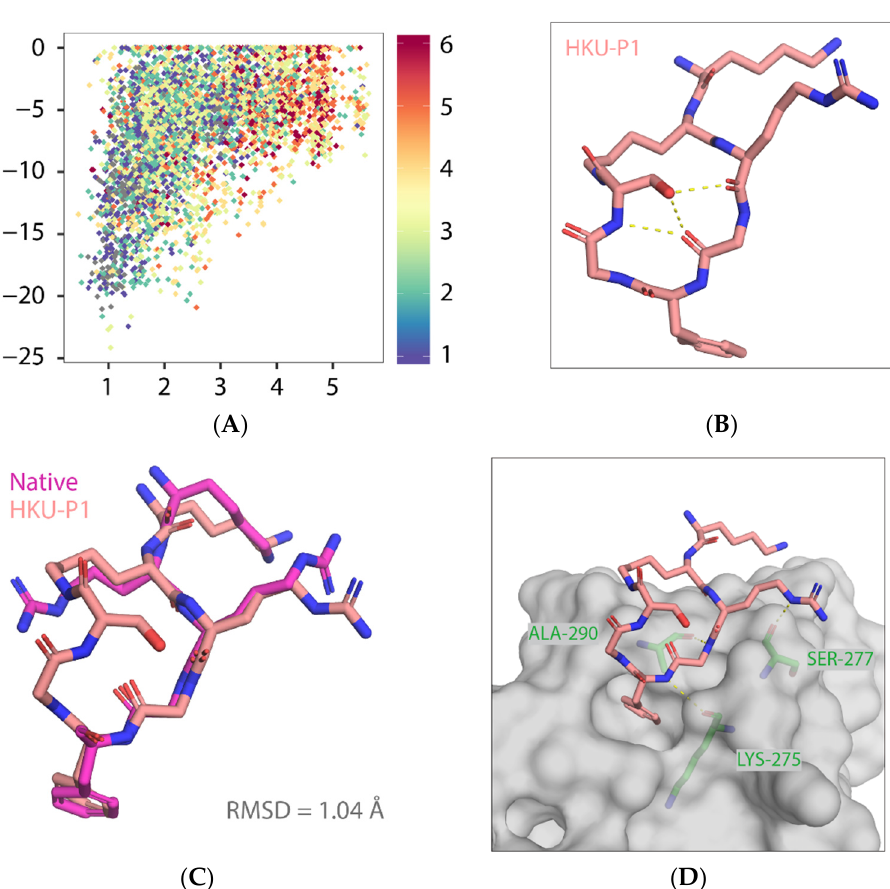
Figure 4. Predicted binding mode of HKU-P1 to SFTSV Gn. ( A ) Conformational landscape analysis of HKU-P1 bound to SFTSV Gn, showing computed binding energy against RMSD to native pentapeptide. Each point represents a conformational sampling attempt succeeded in cyclization. Colors indicate the number of intramolecular hydrogen bonds. ( B ) Intramolecular hydrogen bonding in top conformation of HKU-P1; hydrogen bonds were indicated with yellow dashed lines. ( C ) Overlay of top conformation and native pentapeptide. The RMSD value of aligned part was labelled. ( D ) Binding mode of HKU-P1 top conformation to the SFTSV Gn surface. HKU-P1 top conformation and SFTSV Gn were represented by sticks and surfaces, respectively. Hydrogen bonding residues of SFTSV Gn were shown in green sticks and labelled, and hydrogen bonds were indicated with yellow dashed lines. Table 1. Effect of combinatorial HKU-P1 and favipiravir on SFTSV replication. The favipiravir IC 50 at each concentration of HKU-P1 was calculated using non-linear regression analysis in